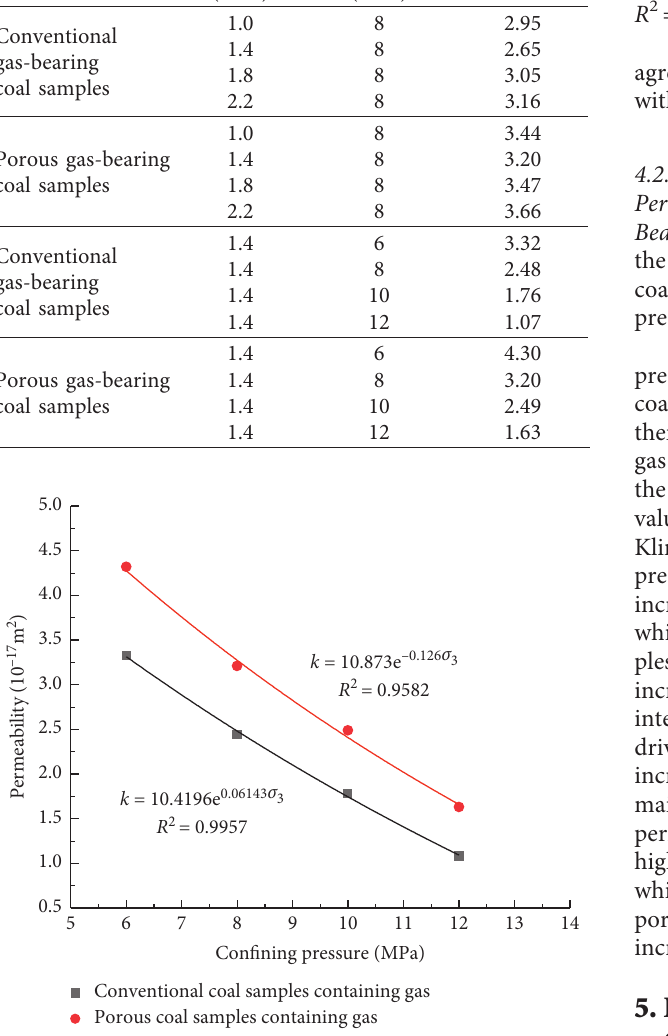
Figure 5: Change of permeability of porous and conventional gas- bearing coal samples with confining.